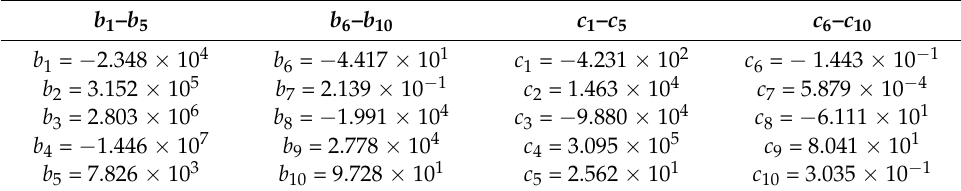
Table 2. Constants used to calculate the enthalpy and entropy of seawater